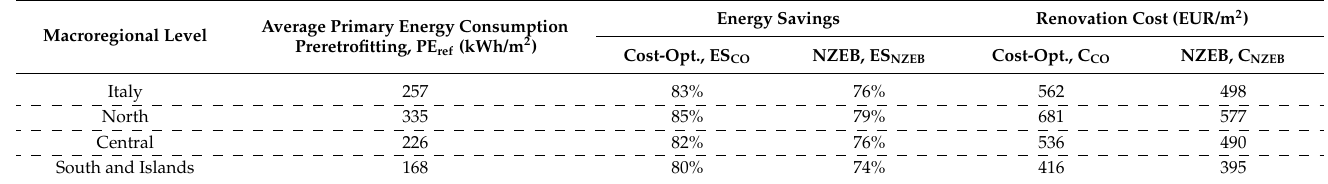
Table 6. Main input data for SFH (preretrofitting primary energy, percentual energy savings and renovation costs) collected for the Italian macroregions.